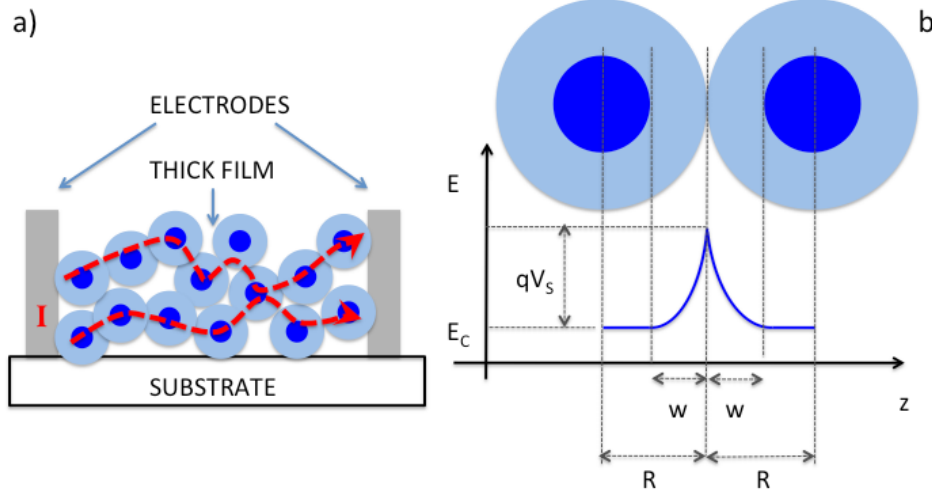
Figure 2. Schematic representation of the structure ( a ) and working principle ( b ) of thick film gas